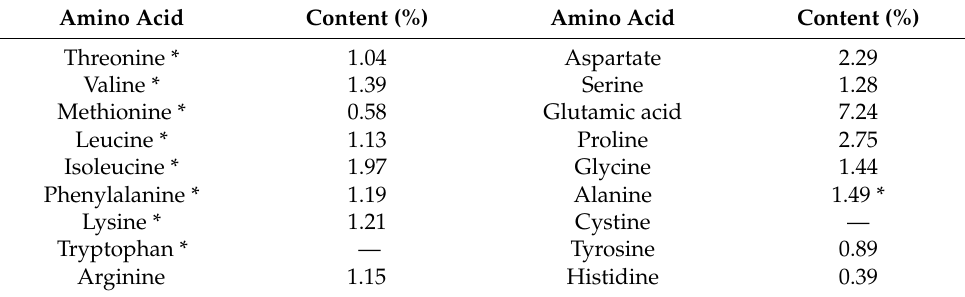
Table 2. Amino acids found in T. sinensis